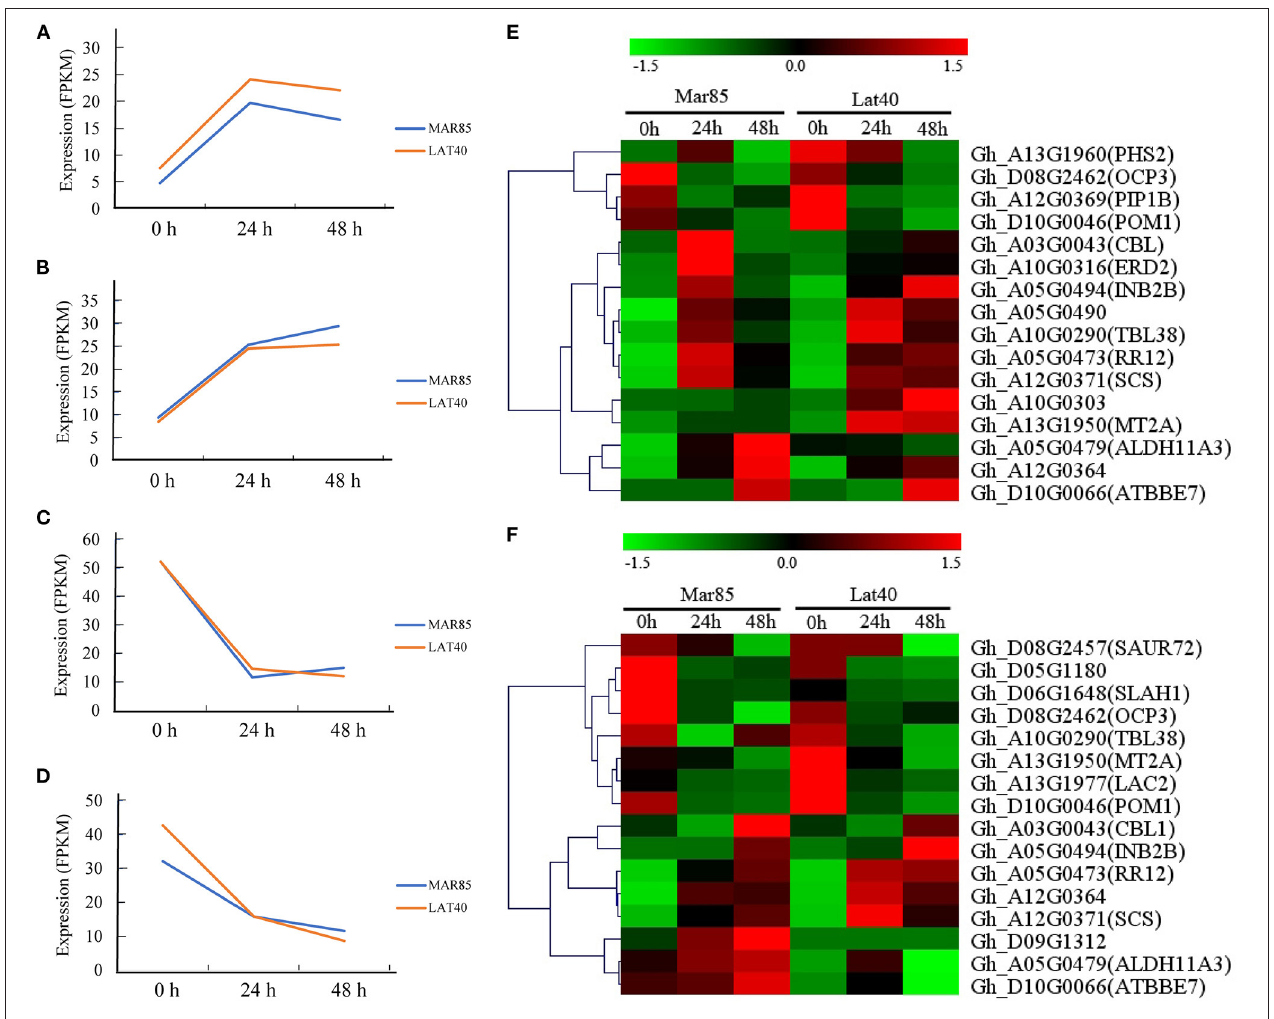
FIGURE 5 | The expression change trends of selected genes. (A) Genes down regulated in leaf tissue. (B) Genes down regulated in root tissue. (C) Genes up regulated in leaf tissue. (D) Genes up regulated in root tissue. (E) expression pattern of drought-tolerance candidate genes in leaf tissue. (F) expression pattern of drought-tolerance candidate genes in root